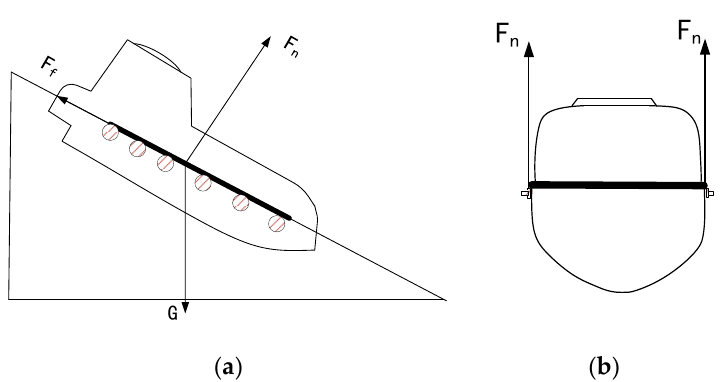
Figure 3. The side view ( a ) of forces and front view ( b ) of supporting force acting on the boat at the skid. The lifeboat is located on the contact rollers on both sides of the skid. The top point of the rollers is in contact with the boat and provides supporting force and friction.